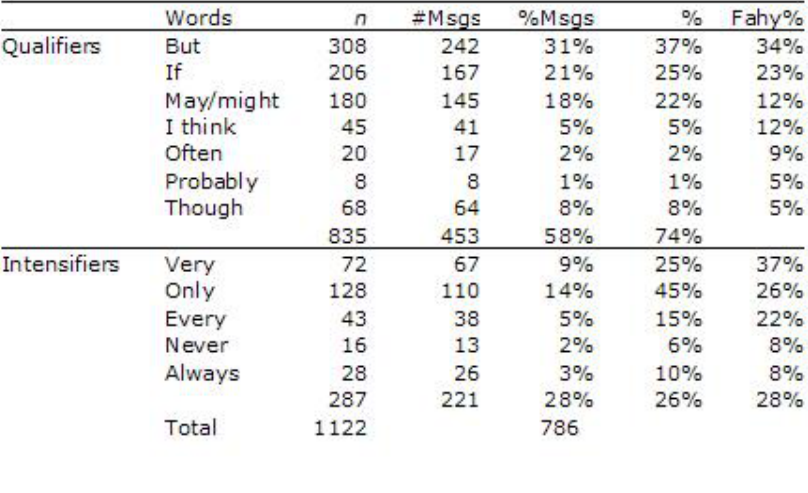
Table 1. Frequency of qualifiers and intensifiers observed in study